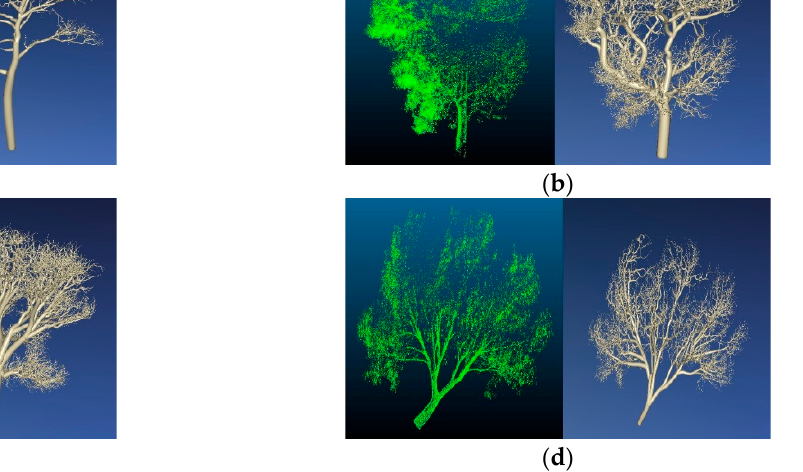
Figure 6. Reconstruction results corresponding to ( left ) tree point cloud of four different morphol- ogies ( right ) are shown. ( a ) This is a young tree; ( b ) this tree has a large crown with distinctive features ( c ) this tree has dense branches and leaves. ( d ) The tree is deformed and the trunk is not perpendicular to the ground.